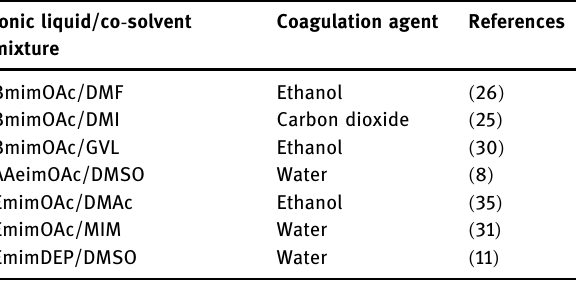
Table 6: Examples of imidazolium - based ionic liquid/co - solvent mixtures and coagulation agents used for the regeneration